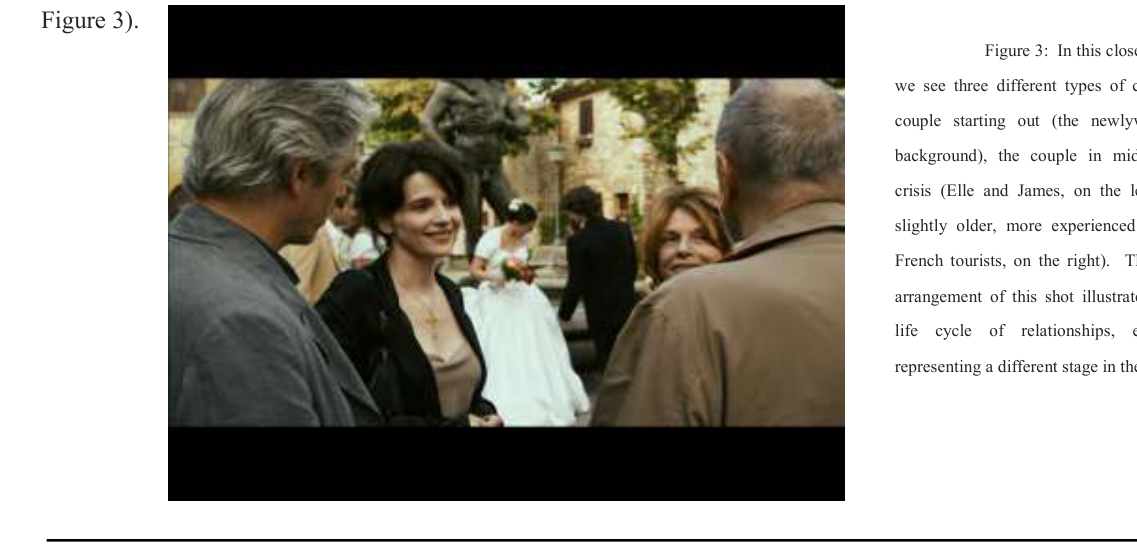
Figure 3: In this closed-form shot, we see three different types of couples: the couple starting out (the newlyweds in the background), the couple in mid-relationship crisis (Elle and James, on the left), and the slightly older, more experienced couple (the French tourists, on the right). The deliberate arrangement of this shot illustrates a familiar life cycle of relationships, each couple representing a different stage in the